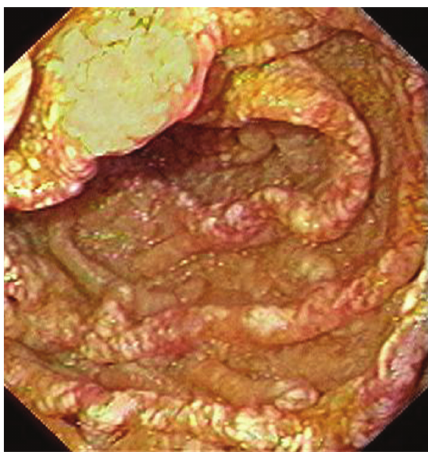
Figure 5: Whipple’s disease: picture of the jejunum. Characteristic whitish areas protrude the above surrounding relief.